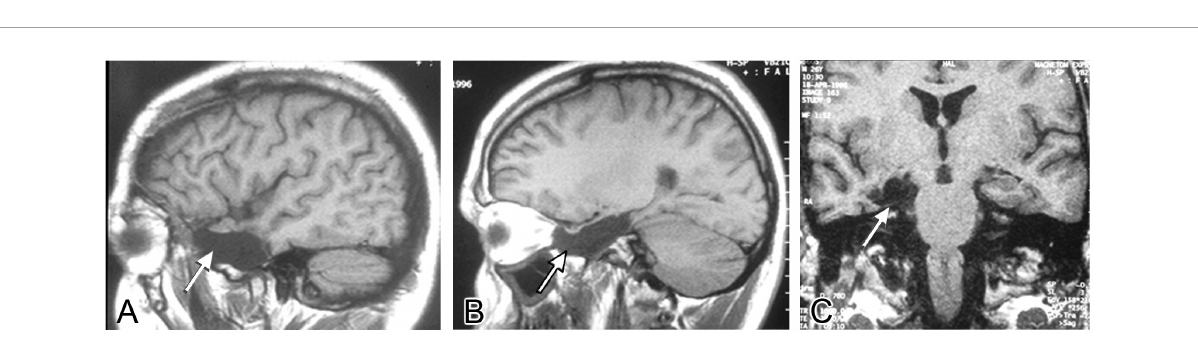
FIGURE3 MRI control after surgery. MRI images illustrating the surgical resection of the temporal neocortex and uncus-amygdala-hippocampal complex (arrows) from the same patient. (A,B) Sagittal planes, (C) coronal